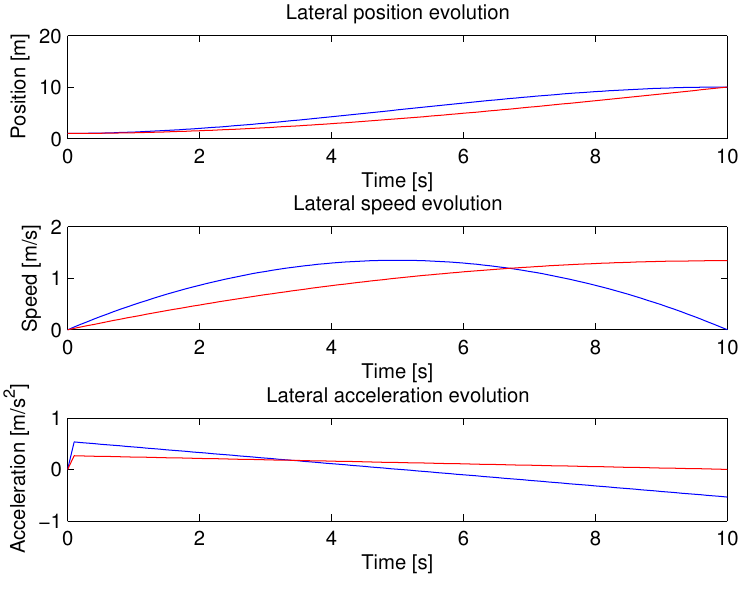
= 10 s). (red) ( t D 2 f